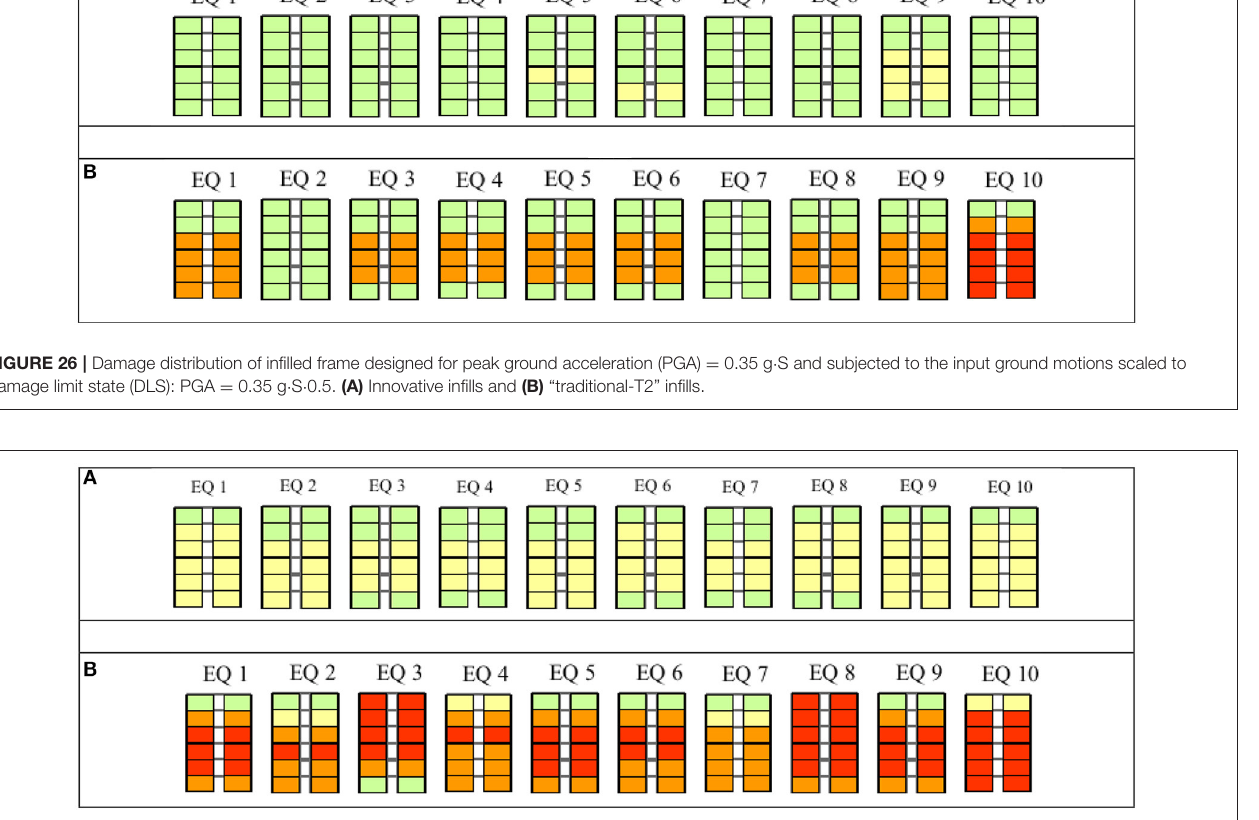
FIGURE 27 | Damage distribution of infilled frame designed for peak ground acceleration (PGA) = 0.35 g · S and subjected to the input ground motions scaled to life safety limit state (LSS/ULS): PGA = 0.35 g · S. (A) Innovative infills and (B) “traditional-T2”